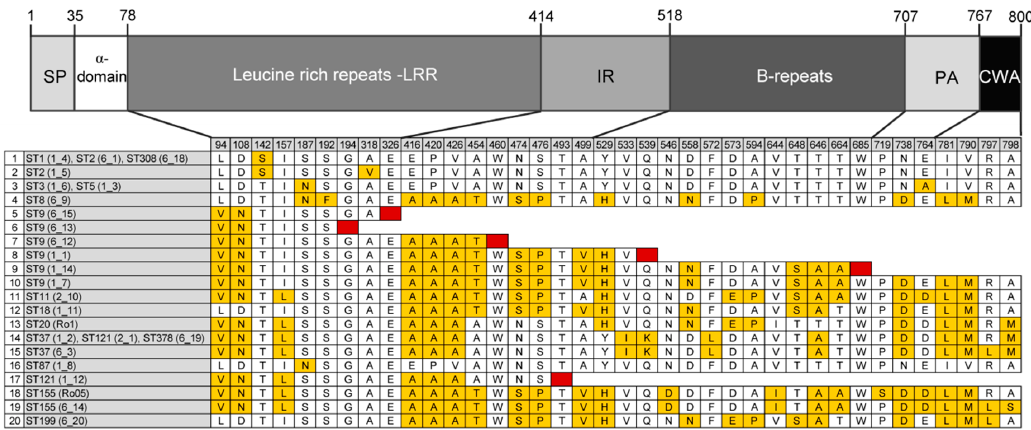
Figure 3. Internalin A variants. Analysis of InlA amino acid sequence of 57 L. monocytogenes isolates revealed 20 different variants. InlA functional domains are represented as distinct blocks: signal peptide (SP), leucine rich repeats (LRR), intragenic repeat (IR), B-repeats, pre-anchor domain (PA), and cell wall anchor (CWA). Different variants are presented by one representative strain. Red indicates premature stop codon (PMSC).